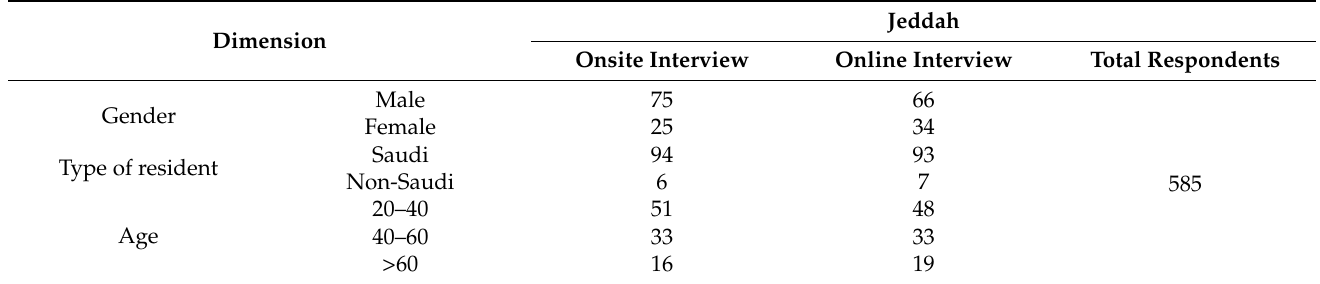
Table 2. Socio-demographic profile of the respondents